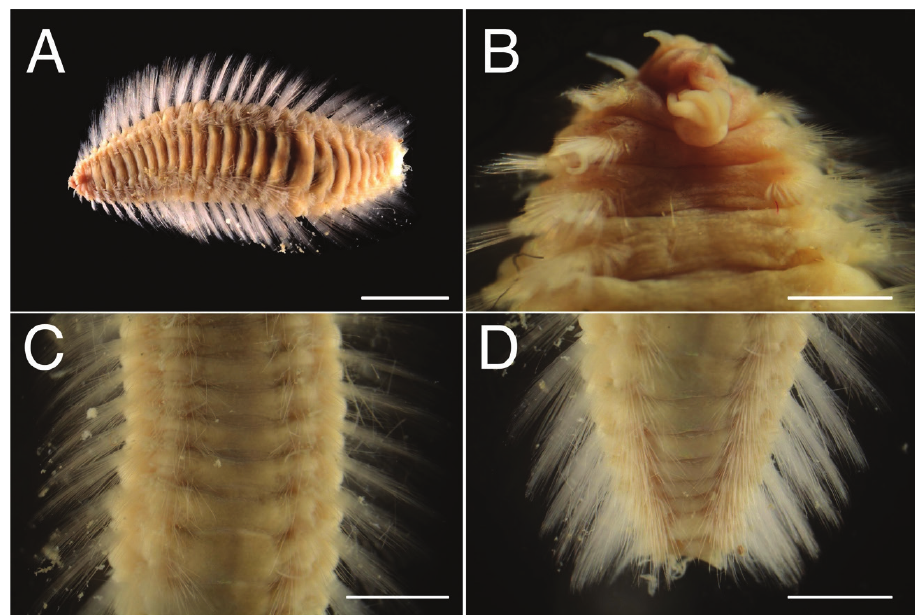
Figure 1. Benthoscolex seisuiae sp. n., holotype (NSMT-Pol H-676). A whole body, dorsal view B an- terior end, dorsal view C median body, dorsal view D posterior end, dorsal view. Scale bars: 5 mm ( A ); 1 mm ( B ); 3 mm ( C–D